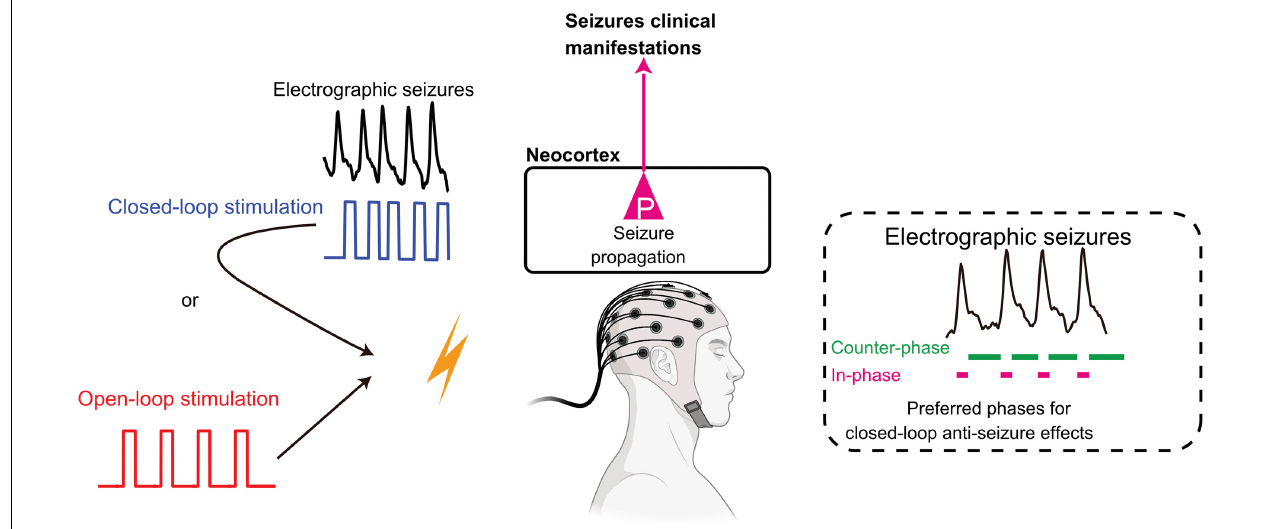
FIGURE 1 | Open-loop and closed-loop interventions in epileptic seizures. Open-loop intervention delivers preset stimulation naive to the ongoing rhythmicity of brain activity., while closed-loop intervention governs stimulation pattern by the real-time processing of network oscillations. Counter-phase stimulation cancels intrinsic oscillations by destructive interference. In contrast, in-phase stimulation can enhance or restore decreased oscillations by constructive interference. See details in the main text. Adapted from Huang et al. (2019) and Takeuchi et al.